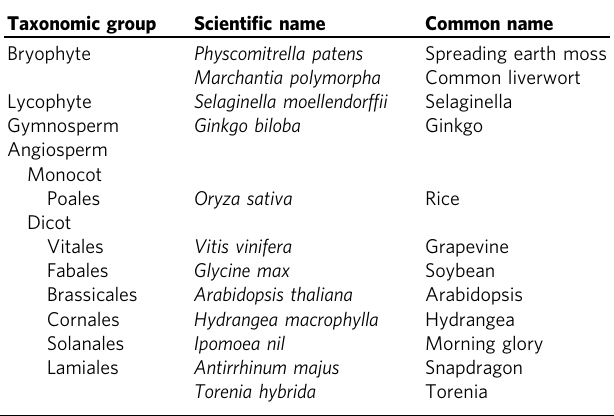
Table 1 Plant sources of CHILs and fl avonoid enzymes used in this